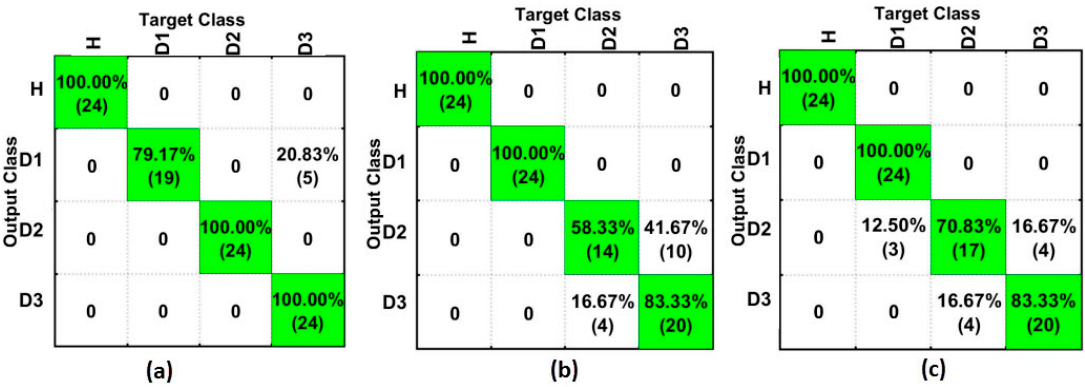
Figure 11. Results for the SFAN-based method (time domain) considering only Savitzky–Golay + First Derivative (SGFD) for: ( a ) PZT#1; ( b ) PZT#2; and, ( c ) PZT#3.